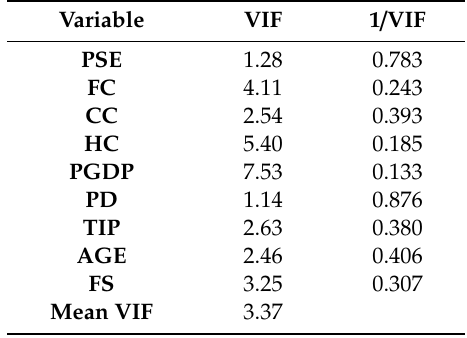
Table A1. Results of the multicollinearity test in the global model.